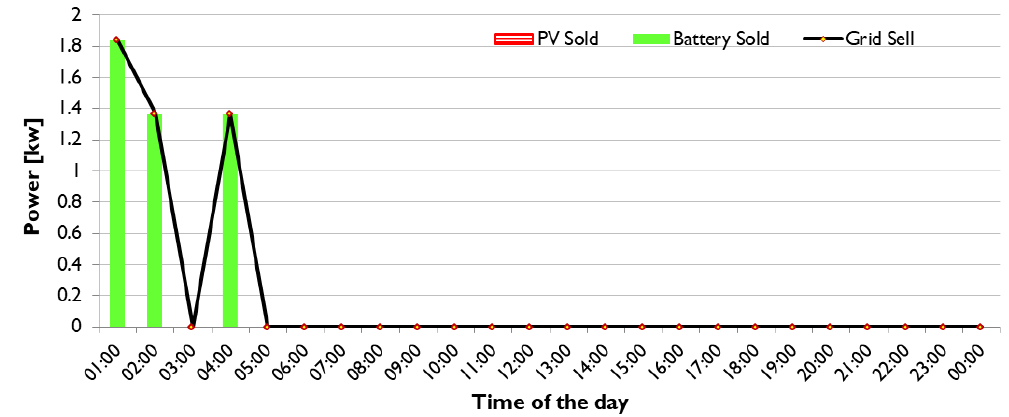
Figure 14. The decomposition of injected power to the grid with PV and battery for sample winter case.